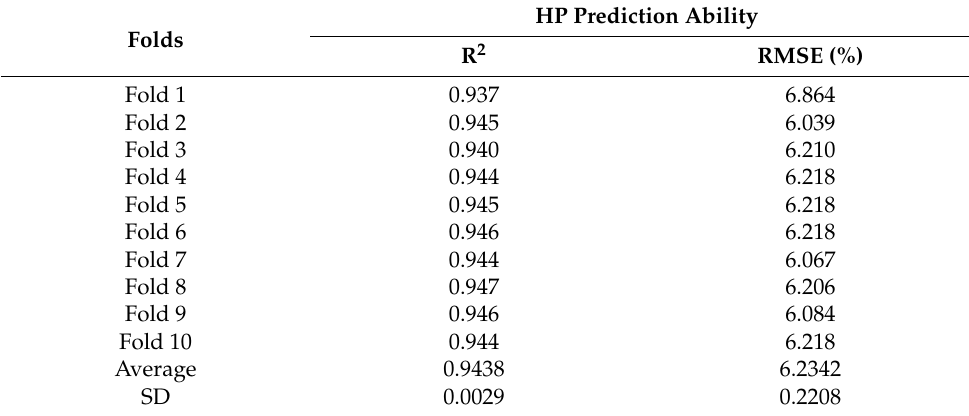
Table 4. R 2 and RMSE results of GBR models with the 10-fold cross validation.